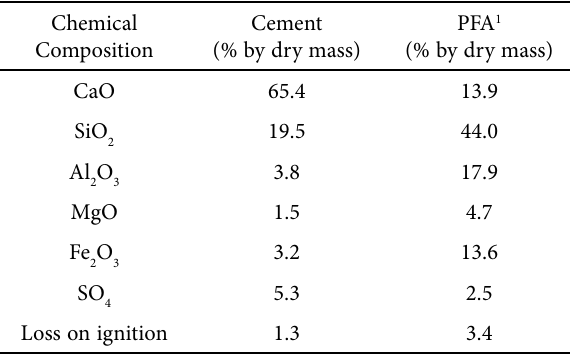
Table 2. Chemical compositions of ordinary Portland